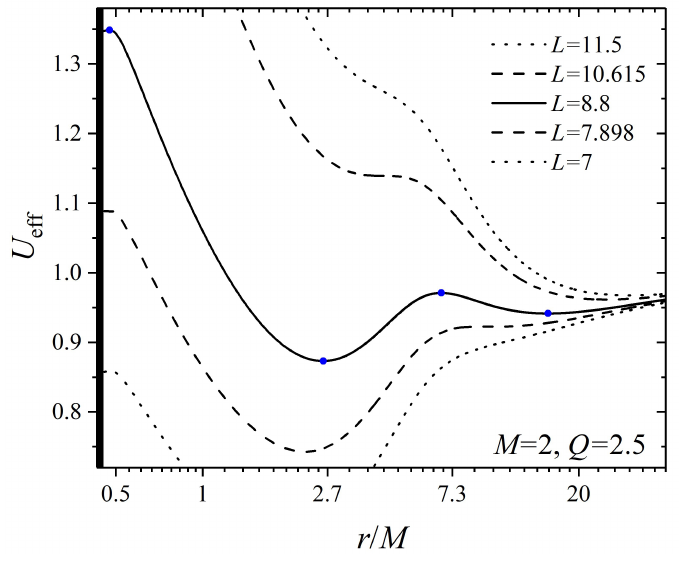
Figure 7. Typical examples of U eff for configuration with U 2 SCOD type. The blue points show the corresponding extrema. There is only one minimum for large L